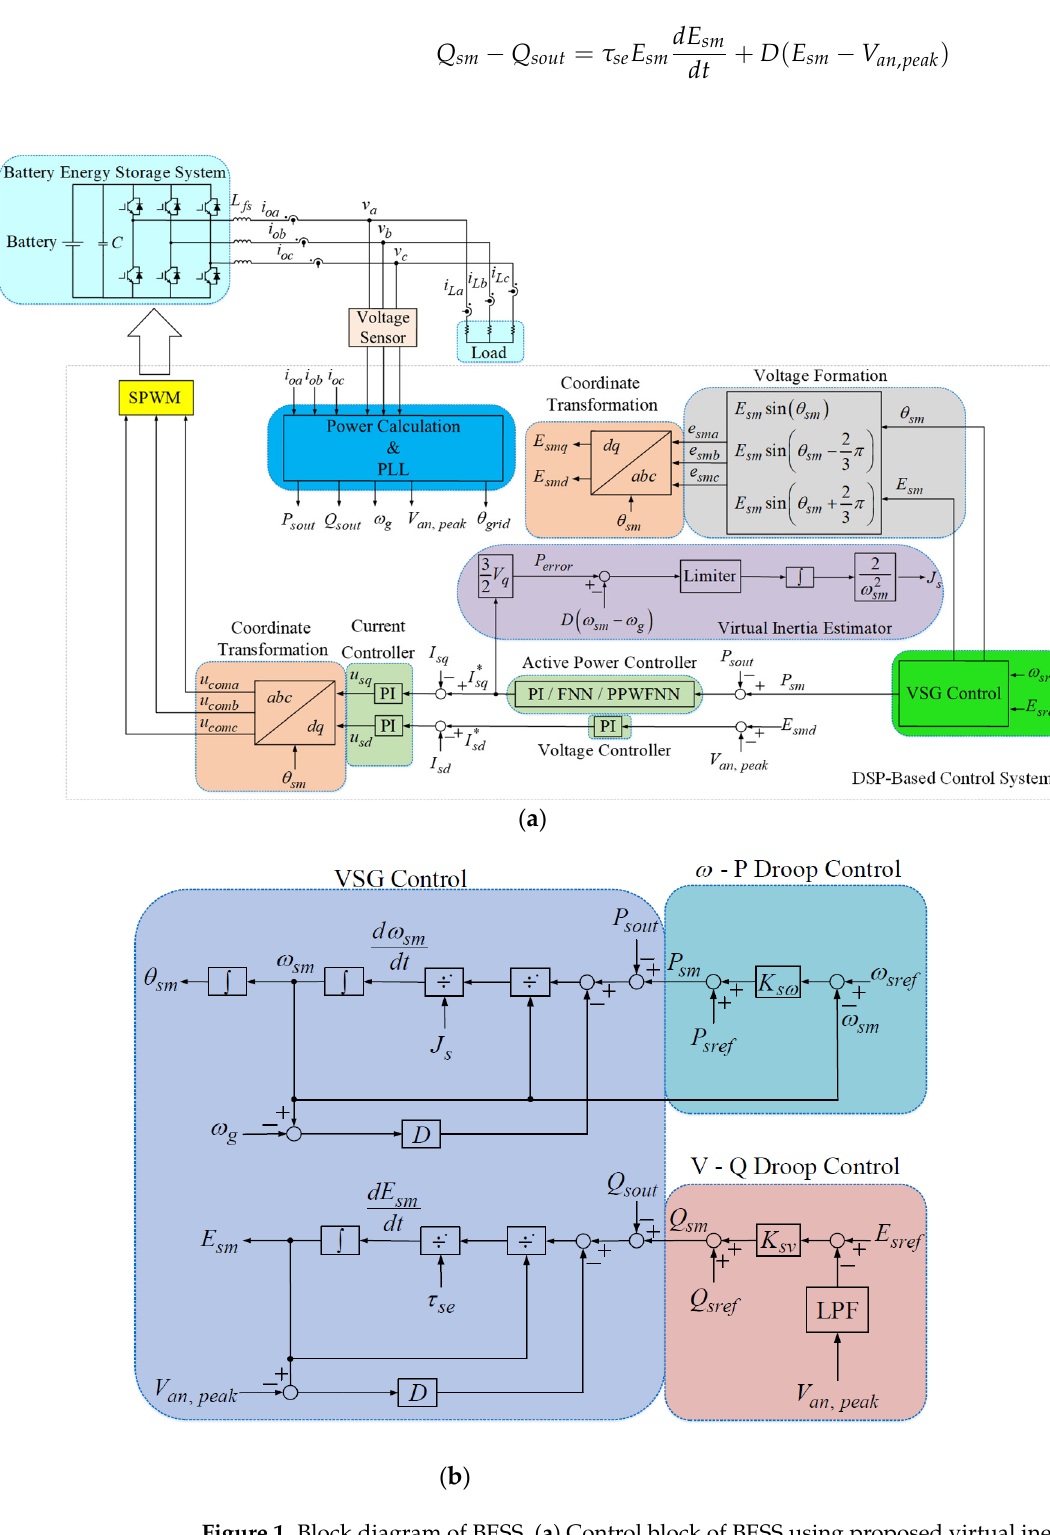
Figure 1. Block diagram of BESS. ( a ) Control block of BESS using proposed virtual inertia estimator and PPWFNN intelligent controller; ( b ) control block of VSG based on droop control.